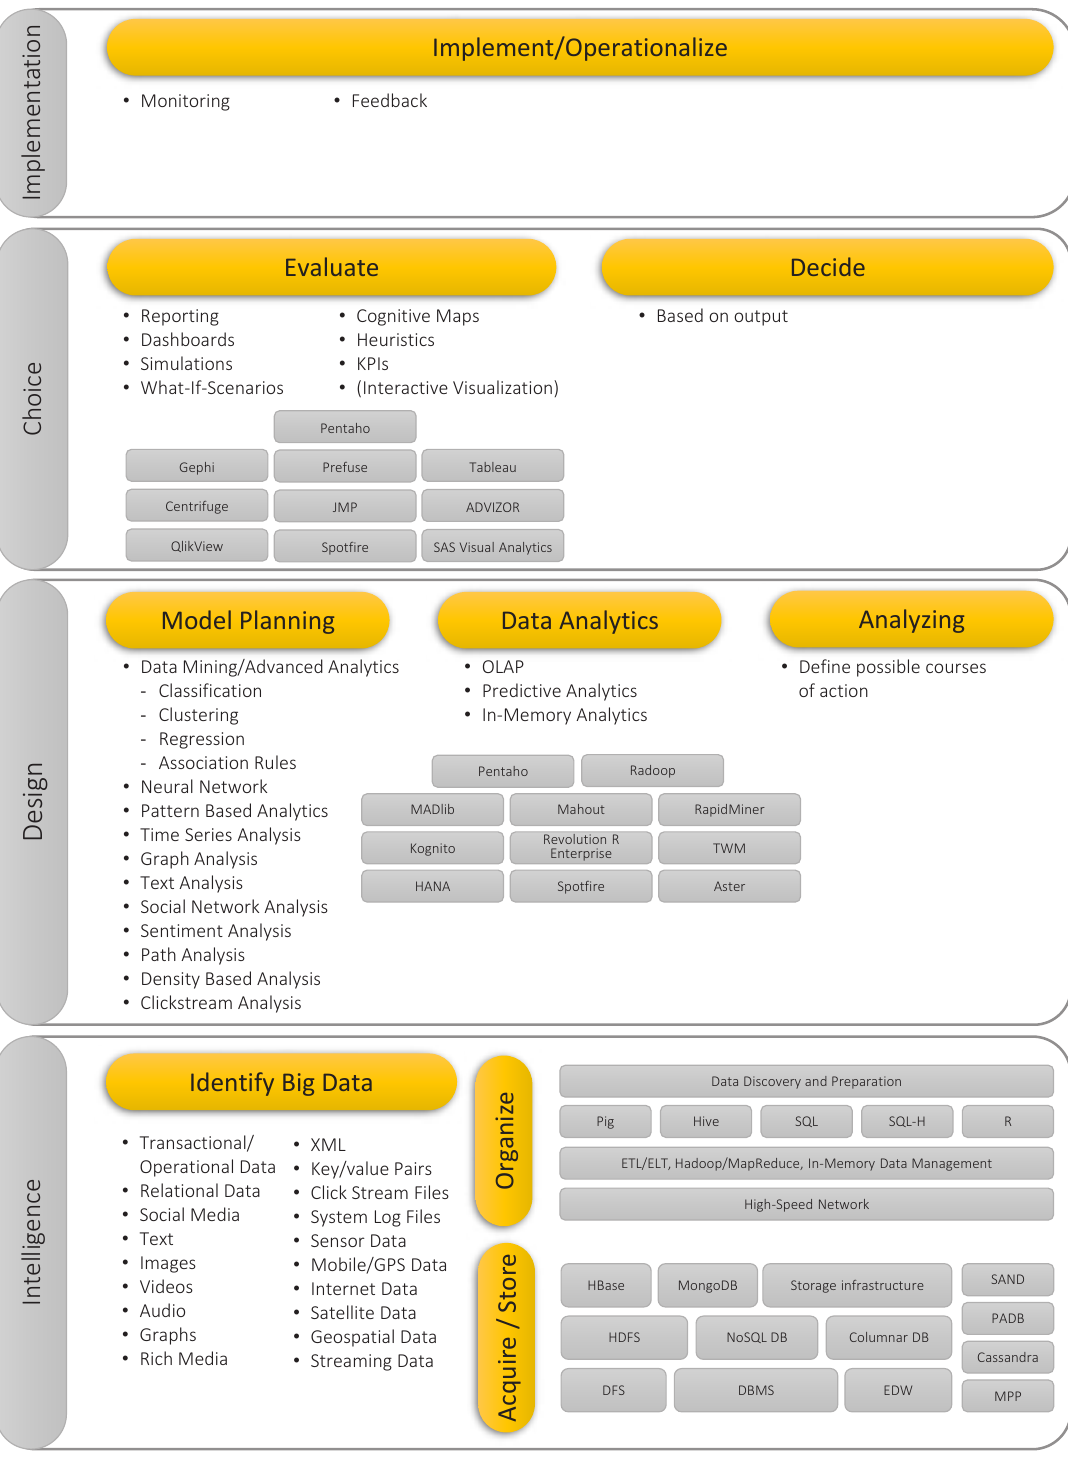
ADVIZOR SAS Visual